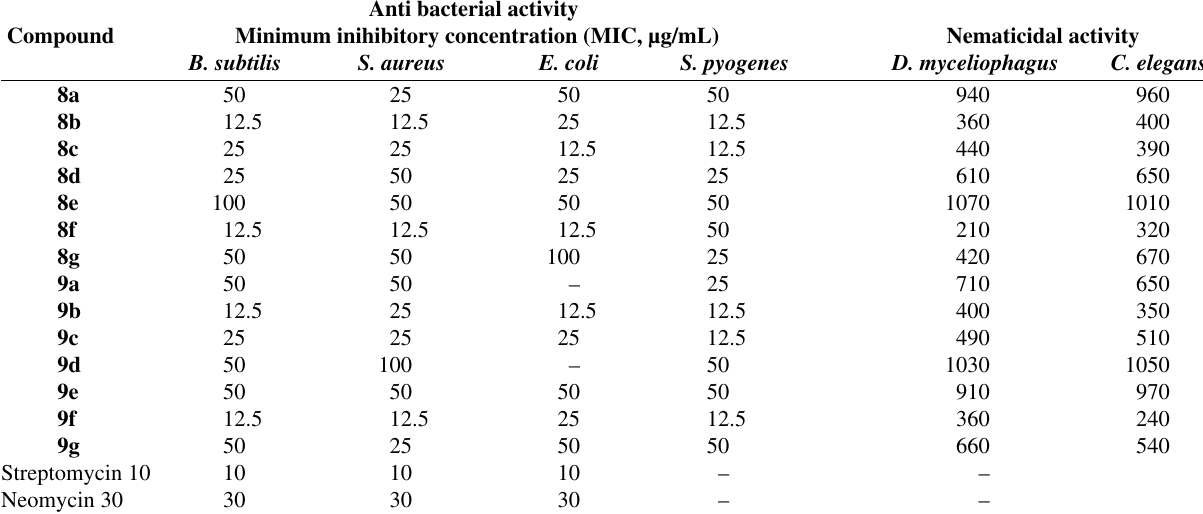
Table 2. Antibacterial and nematicidal activity of 8a – g and 9a – g